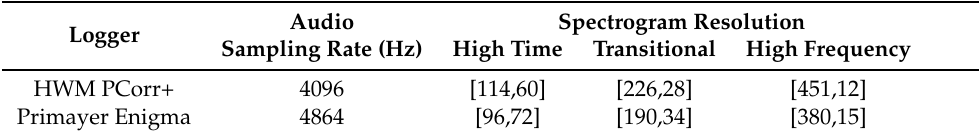
Table 2. TFCNN model spectrogram matrix sizes for different resolutions.